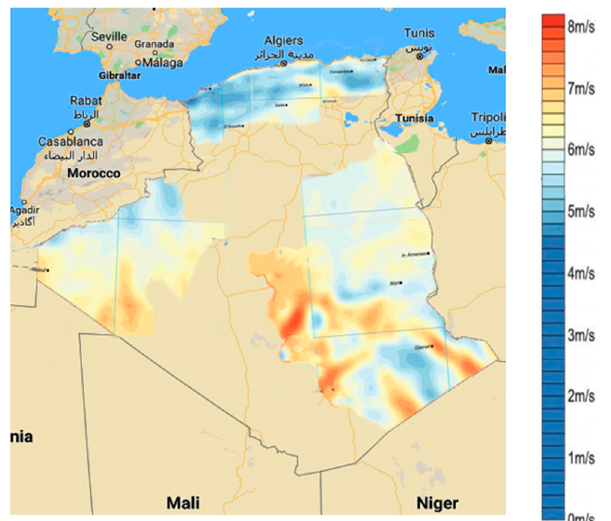
Figure 11. The wind speed potential in Algeria.